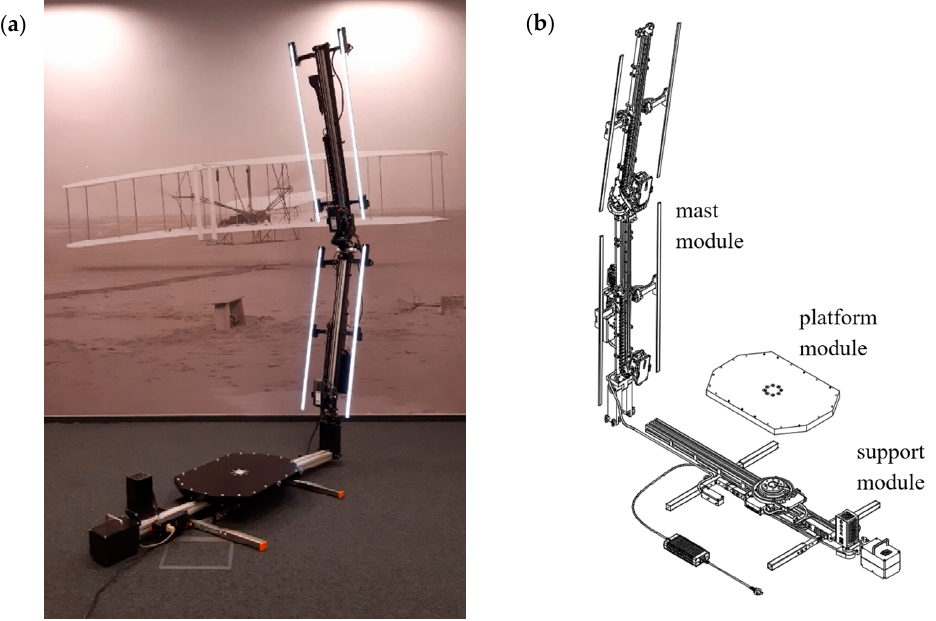
Figure 2. HUBO scanner: ( a )—scanner design, ( b )—illustration of the modular structure of the scan- ner.